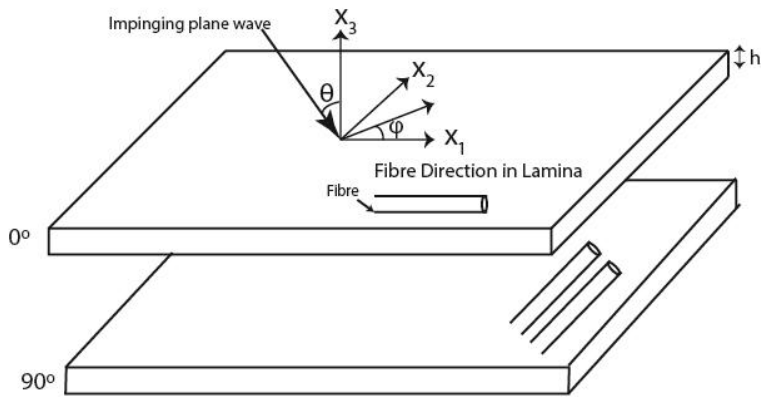
Figure 1. Carbon fiber reinforced plastic (CFRP) laminas specifying the local axis.